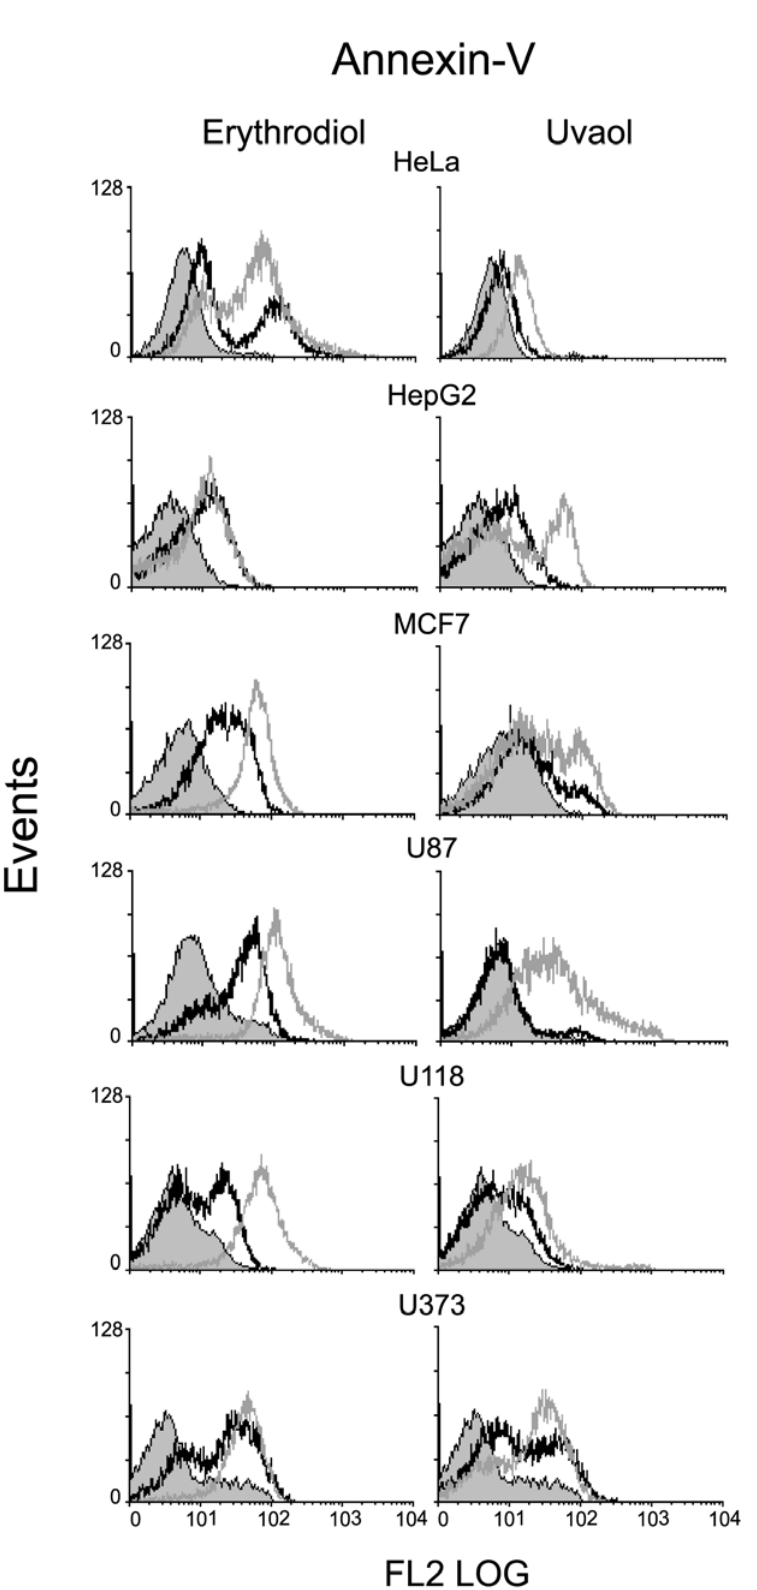
Figure 8. Effect of triterpenic diols on different tumor cell types. The indicated cell types were treated without or with 25 m M ( black empty curve) or 50 m M ( grey empty curve) of erythrodiol or uvaol for 24 h and stained with annexin-V PE. Solid gray curves represent labeling of resting/ control cells.